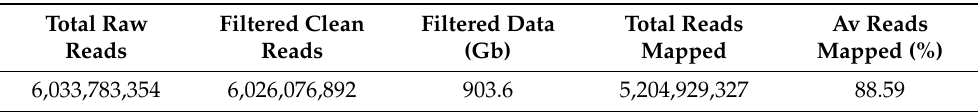
Table 2. Overview of raw data generated, data retained after quality filtering and reads mapped on the reference